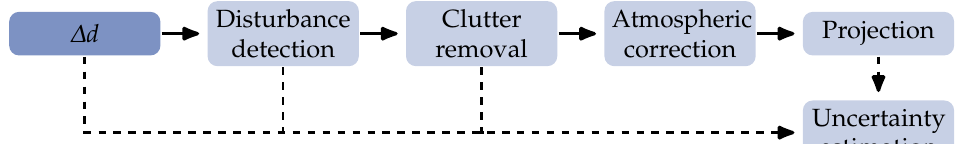
Figure 3. Advanced GBR processing of